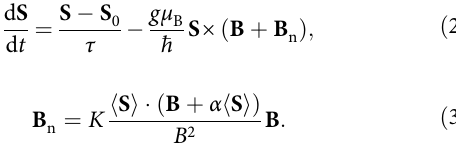
Fig. 4d. The time-dependent DNP drive in Fig. 4c corresponds to the red curve in Fig. 4d. We fi nd that the minima in the DNP drive term coincide with the PSC, directly related to the narrow dips in Δ S at PSC (see Fig. 4b). This reduction of the DNP drive at PSC realigns the initially uniformly distributed electron spin precession frequencies into discrete PSC modes. This leads to spin mode-locking and occurs on a timescale given by the DNP process (evaluated as t ML in the experiment). The spectral width of the dips in Δ S and therefore also of the PSC modes is proportional to the spin decay rate 1/ τ . Importantly, this decay rate is sampled over the build-up time of spin polarization by the laser pulse train, i.e. at most a few τ . Similar to dynamic decoupling protocols and other methods 41 , but here in a self- driven way, this mechanism acts as a high-pass fi lter for nuclear fl uctuations with a cut-off frequency at 1/ τ , leading to a stabilization of nuclear polarization and a corresponding increase in electron spin lifetime. The proposed mechanism in the model works only if a fi nite component of spin polarization is injected along the magnetic fi eld direction. This could occur in case of an (unintentional) misalignment of the magnetic fi eld with respect to the sample plane, together with a non-zero average of the helicity of the pump photons. We therefore measure spin precession in the same sample but with a magnetic fi eld that has been intentionally tilted out-of-plane by an angle of 8°. By adding a Soleil-Babinet (SB) variable retarder after the photoelastic modulator, we control the average helicity of the pump photons while still modulating the retardance at a peak-to-peak amplitude of λ /2 and a frequency of 50 kHz. For the SB set at retardance of 0 ( λ /2), the pump photons are modulated equally between right- and left circular polariza- tion with linear p ( s ) polarization in between. For a retardance of λ /4 (3 λ /4), the pump photons are modulated between p and s linear polarization while going through σ − ( σ + ) polarization. In an oblique fi eld con fi guration, the retardance of λ /4 and 3 λ /4